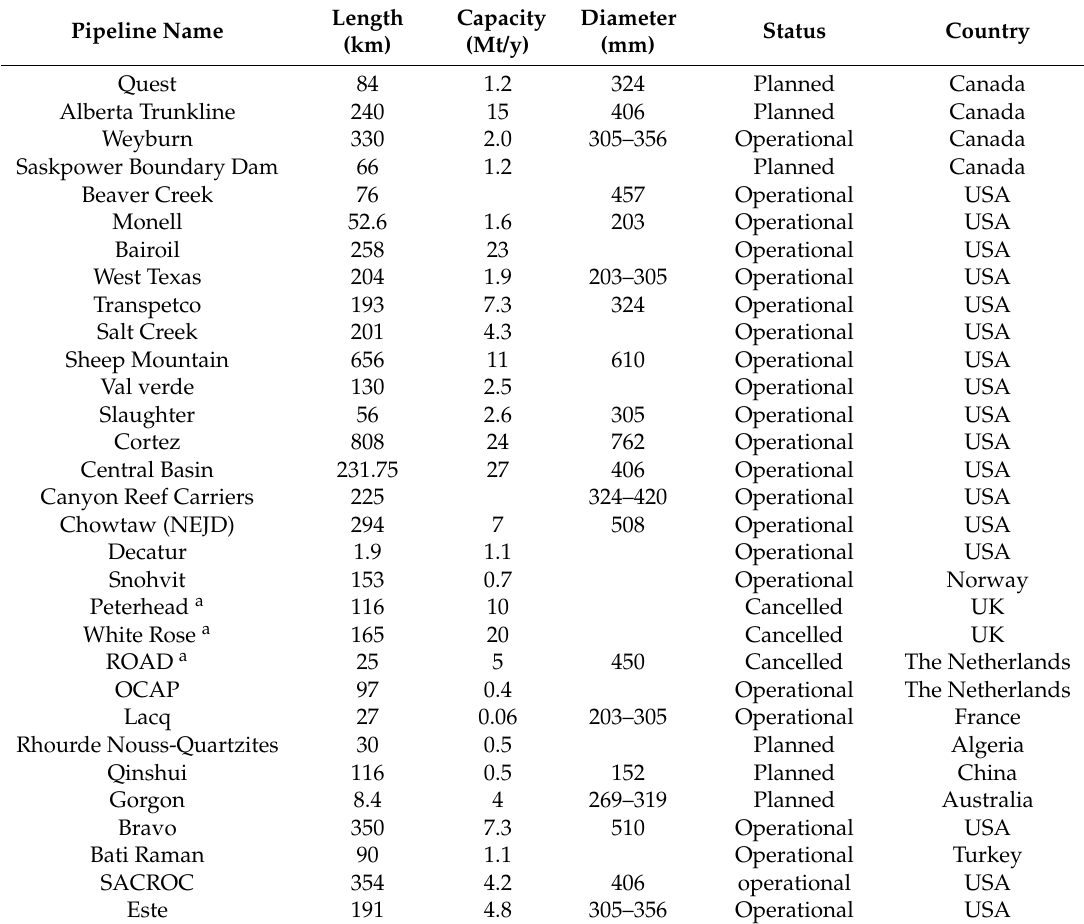
Table 1. Existing and planned CO 2 pipeline projects